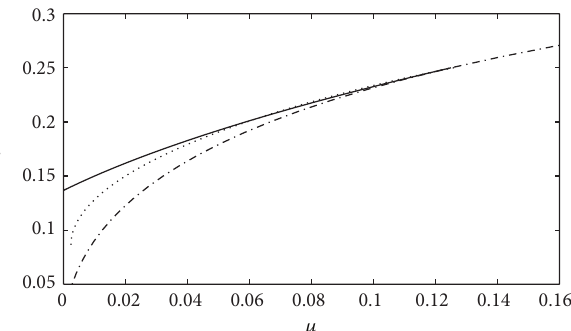
Figure4:Comparisonbetweenthecurveofnonhyperbolicperiodic of (155): the dotted curve was obtained numerically orbits 𝐶 NH with the software MATCONT and the continuous curve from the representation (164). The dot-dashed curve is the Hopf curve.